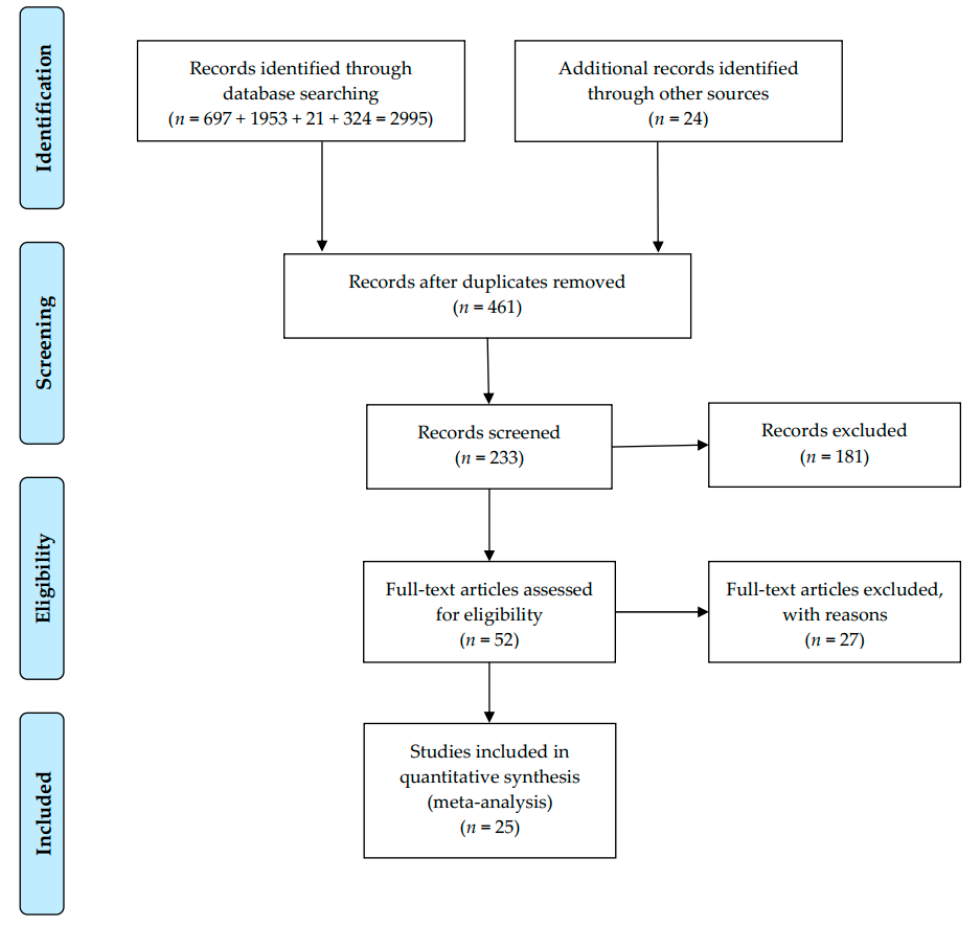
Figure 1. PRISMA flow diagram for meta-analysis.